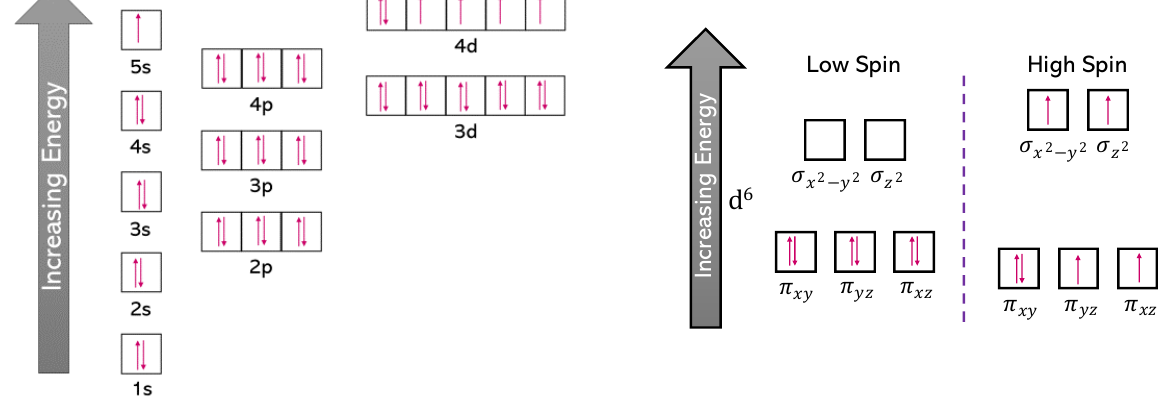
Figure 2. A schematic representation of Ru d 6 atomic orbitals ( left ) as well as the potential molecular orbitals occupations ( right ) are both shown.